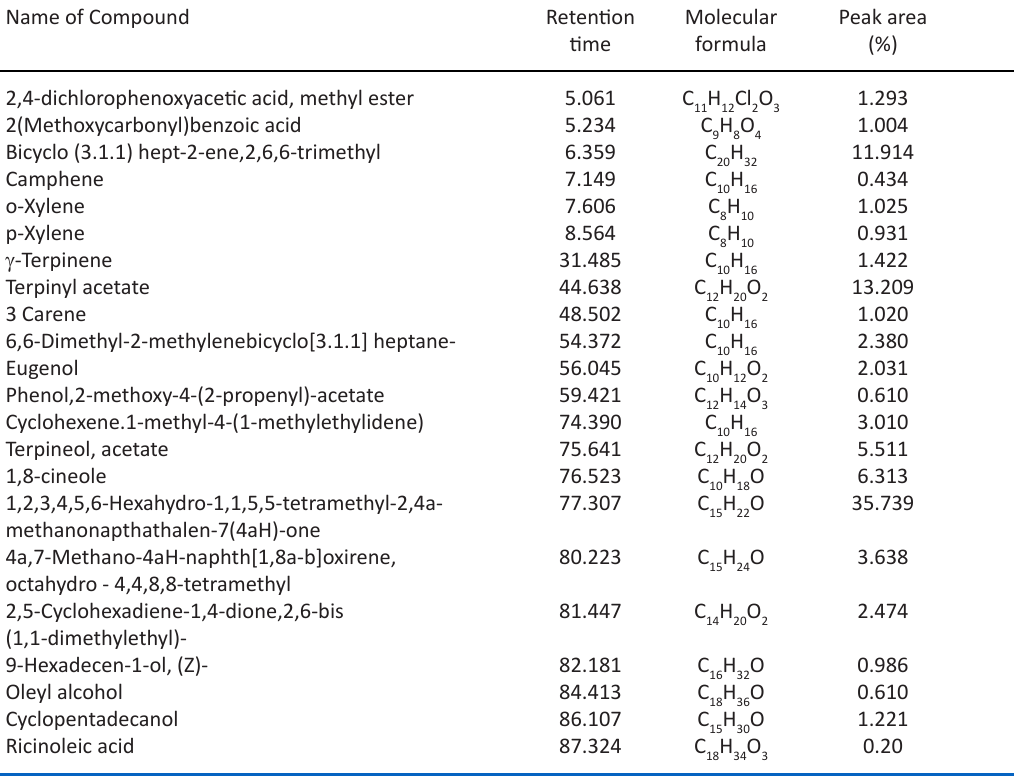
Table 5. GC-MS Analysis of Laurus nobilis Acetone Extract Name of Compound Retention